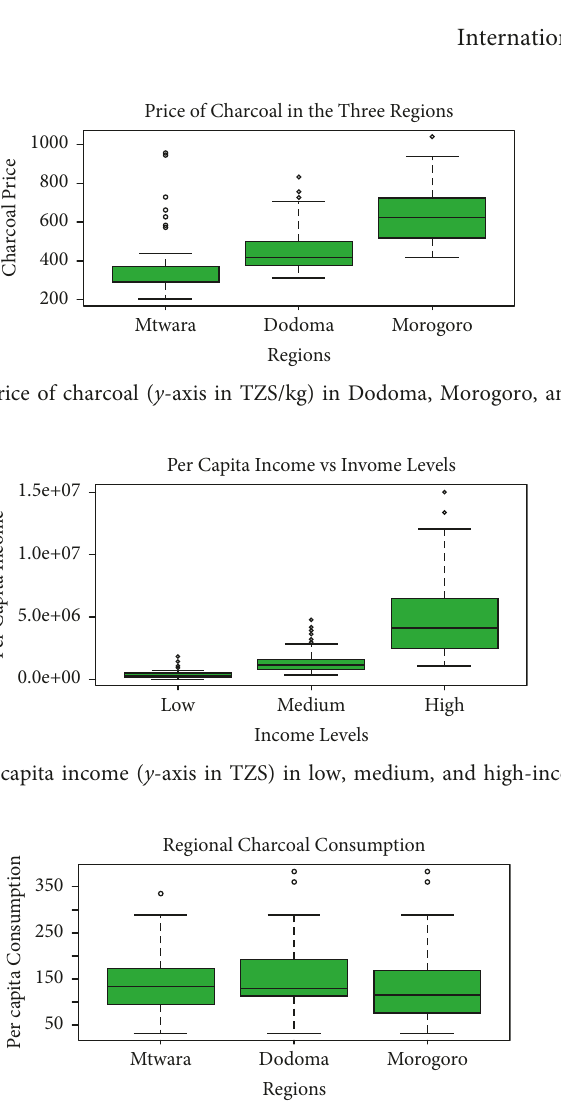
Figure 6: Box-plot of per capita charcoal consumption ( y -axis in kg per year) in Dodoma, Morogoro, and Mtwara ( x -axis). Table 2: Regression results of full sample and three income level samples.